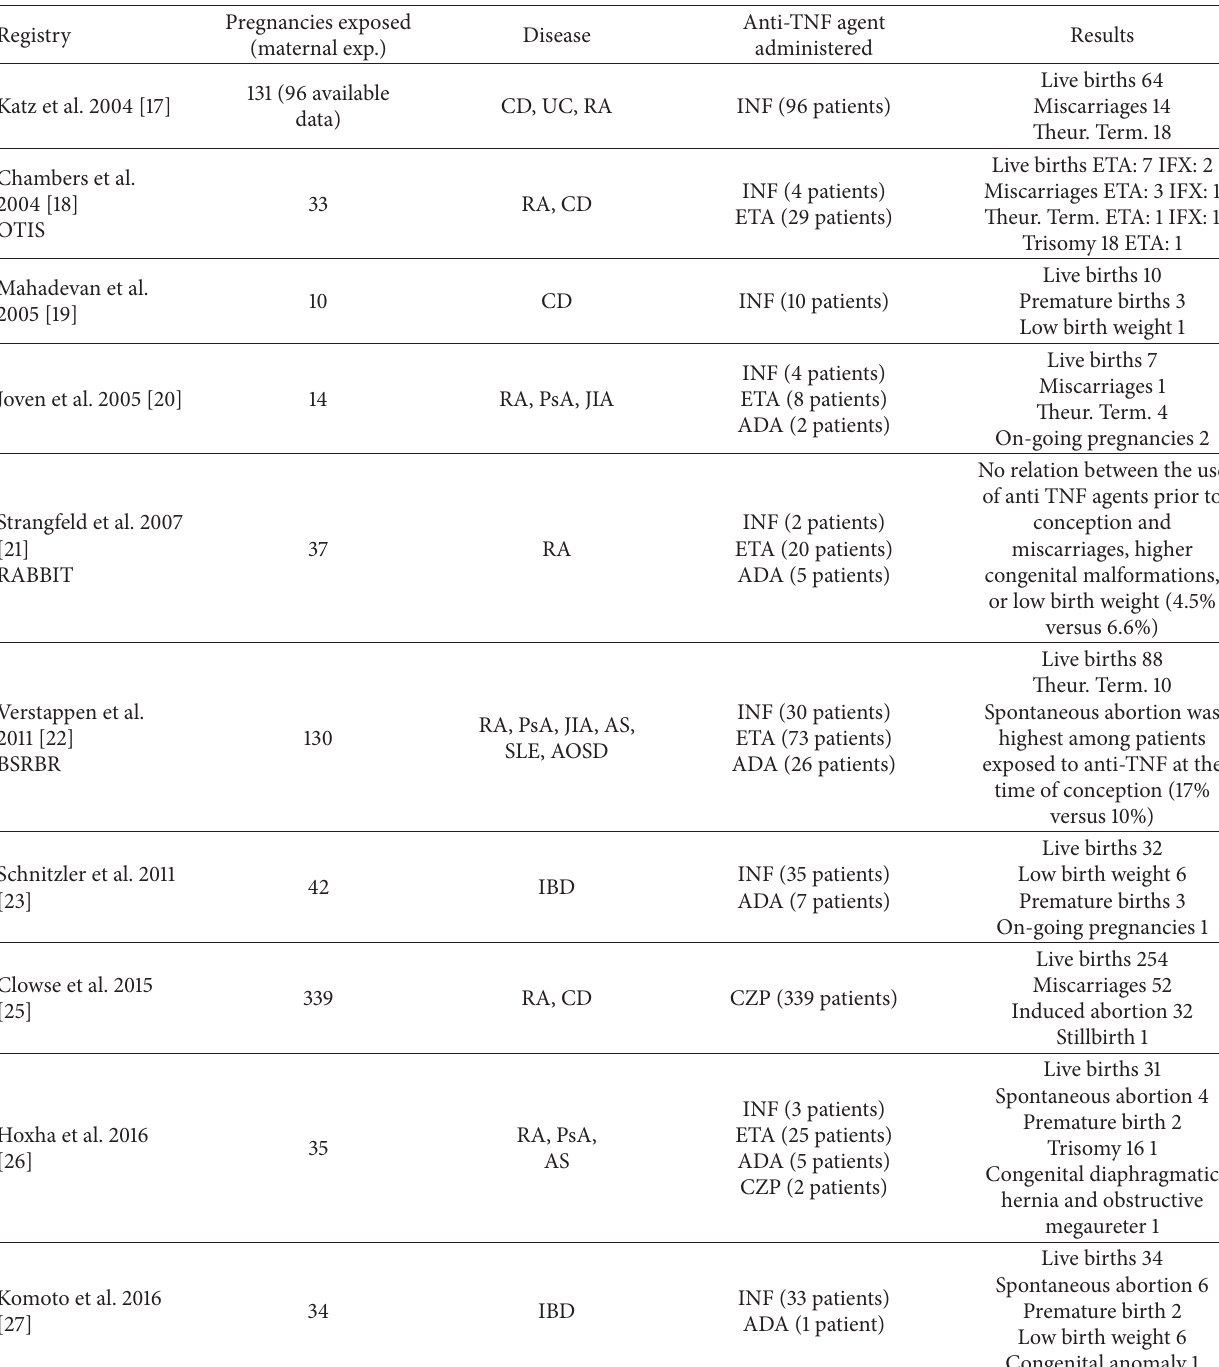
Table 1: Summary of pregnancy outcomes in studies of women with rheumatic diseases exposed to anti-TNF therapy during pregnancy.